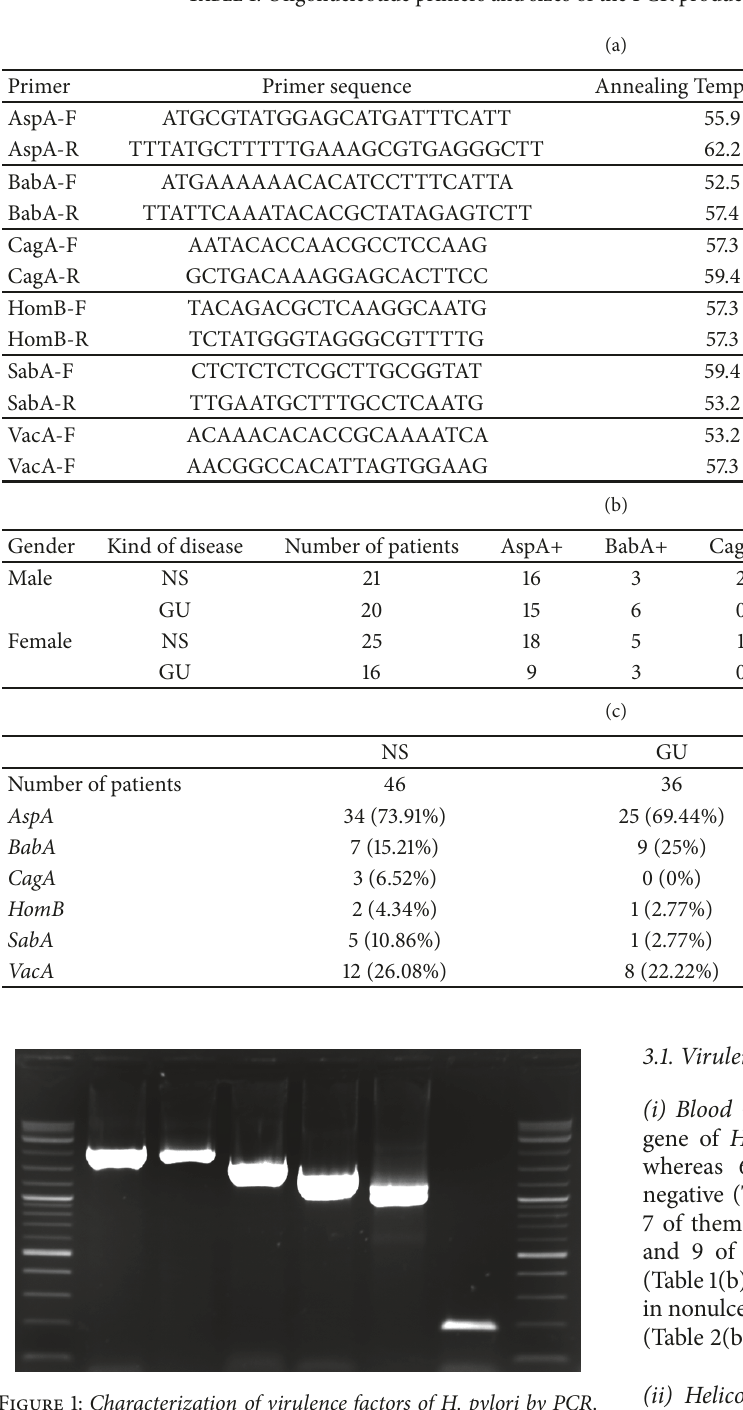
Table 1: Oligonucleotide primers and sizes of the PCR products for virulence factors of H. pylori .